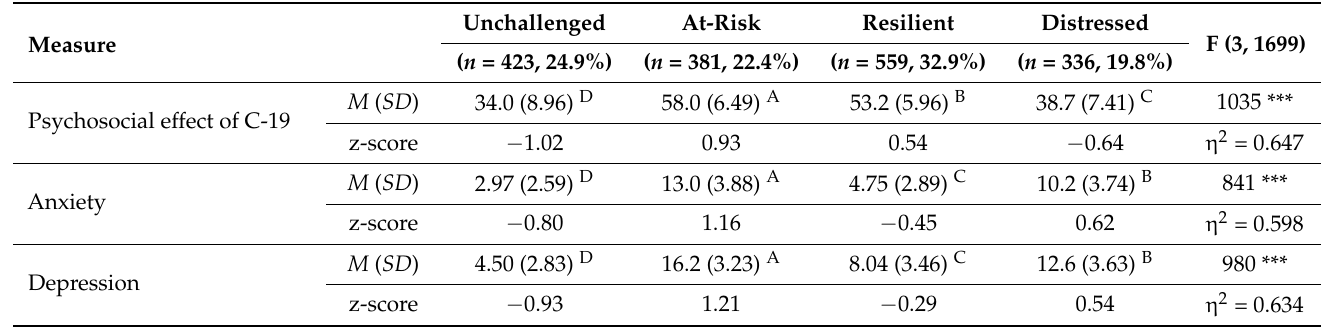
Table 2. Means and Standard Deviations of Psychosocial effect of COVID-19, Anxiety, and Depression for Each Cluster.